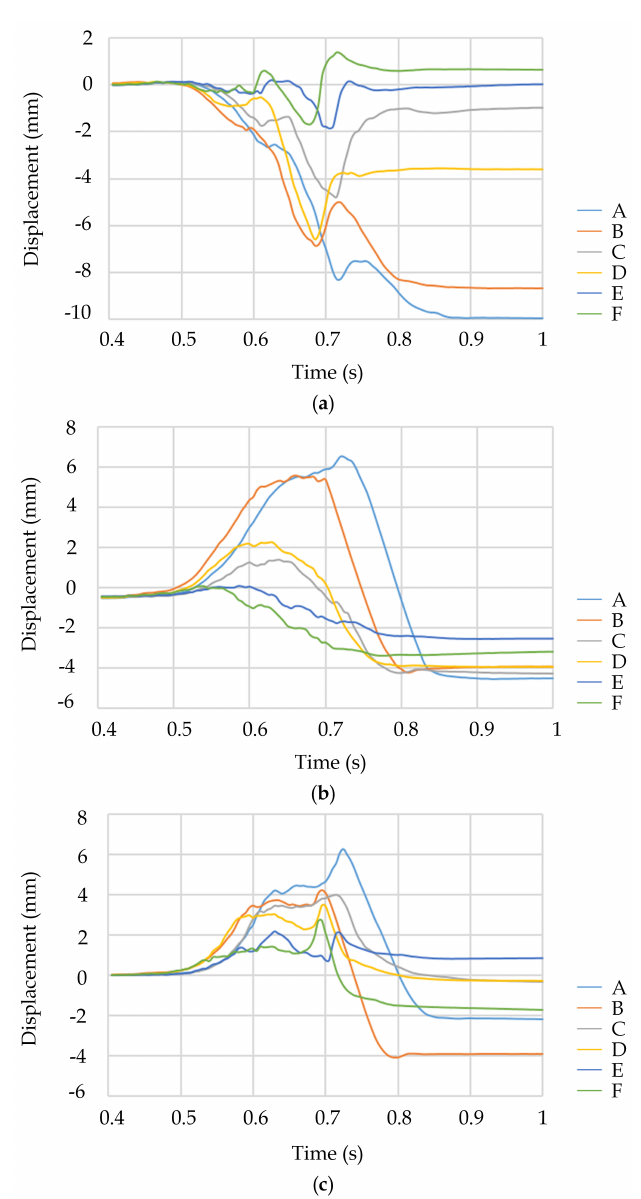
Figure 4. A–F movement process: ( a ) in the X direction; ( b ) in the Y direction; and ( c ) in the Z